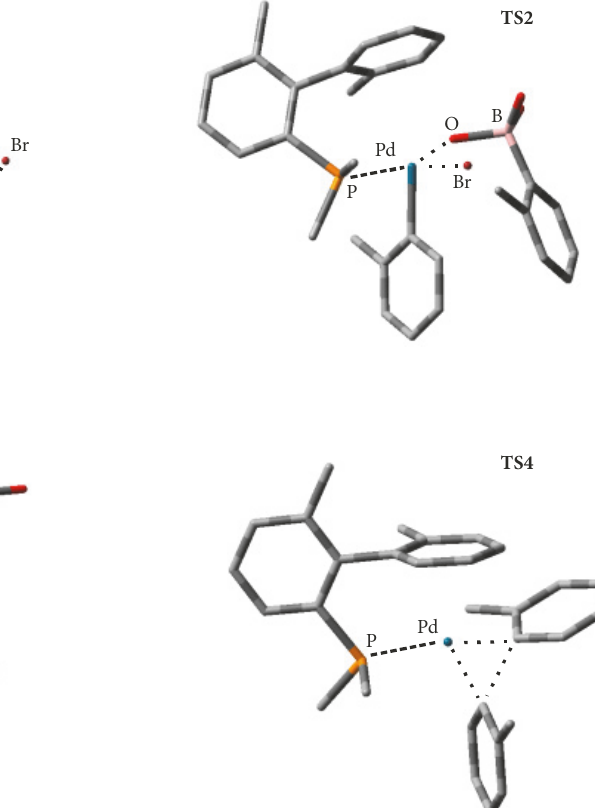
Figure 6: Views of transition states according to DFT calculations.